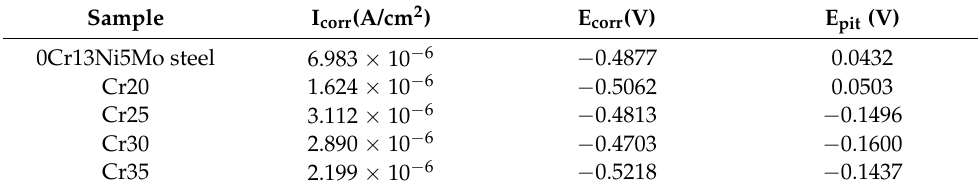
Figure 14. Polarization plots of the 0Cr13Ni5Mo steel and CoCr x FeMnNi HEA coatings in 3.5% NaCl solution (open to air). Table 4. The electrochemical parameters of the HEA coatings and 0Cr13Ni5Mo.